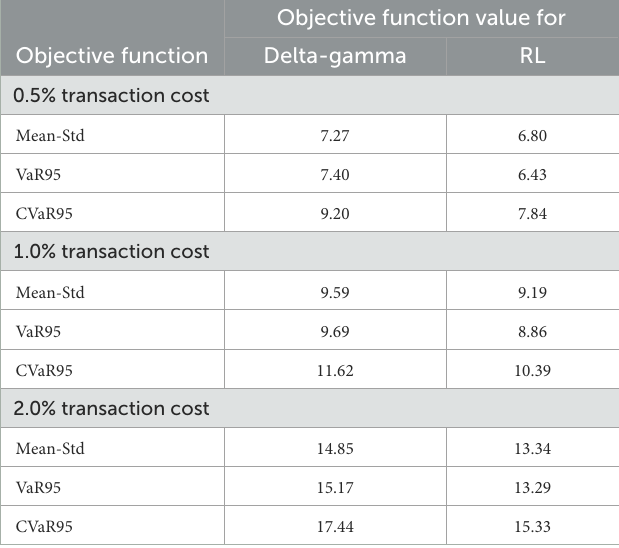
TABLE 2 Results of tests when volatility is